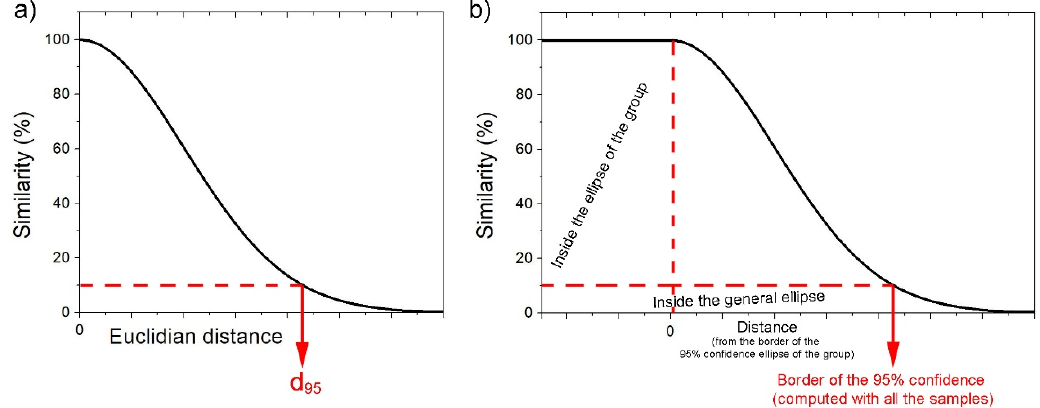
Figure 4. Graphic representation of similarity computation. ( a ) Similarity decreases following a Gaussian function as the Euclidian distance between data increases, fixing a similarity of 10% at a distance d 95 defined as the distance that encompasses 95% of the computed distance distribution. ( b ) Similarly, for data compared to a computed confidence ellipse, similarity is 100% within the ellipse and then decreases in the manner of a Gaussian function fixing a similarity of 10% for data that lie within the border of a 95% confidence ellipse computed with all available data.